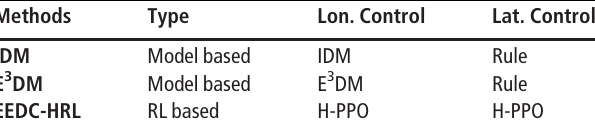
Table 3 Summary of compared methods